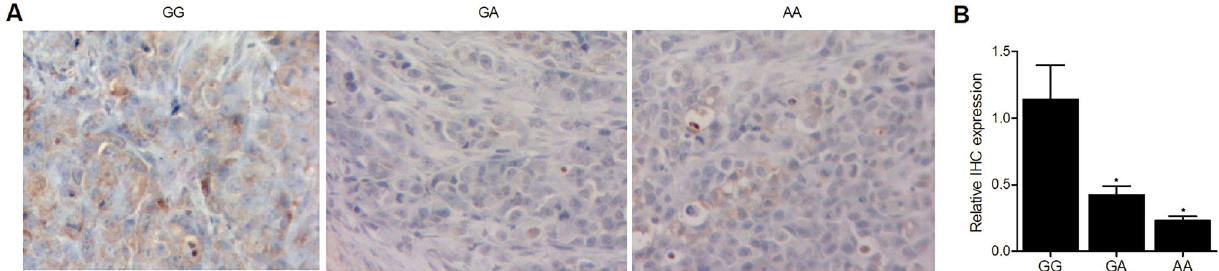
Figure 3. Immunohistochemistry analysis showed that GG polymorphism at rs4911154 was correlated with increased expression of CBL protein in the tissue samples of thyroid nodule patients (*P value < 0.05 vs. GG group).